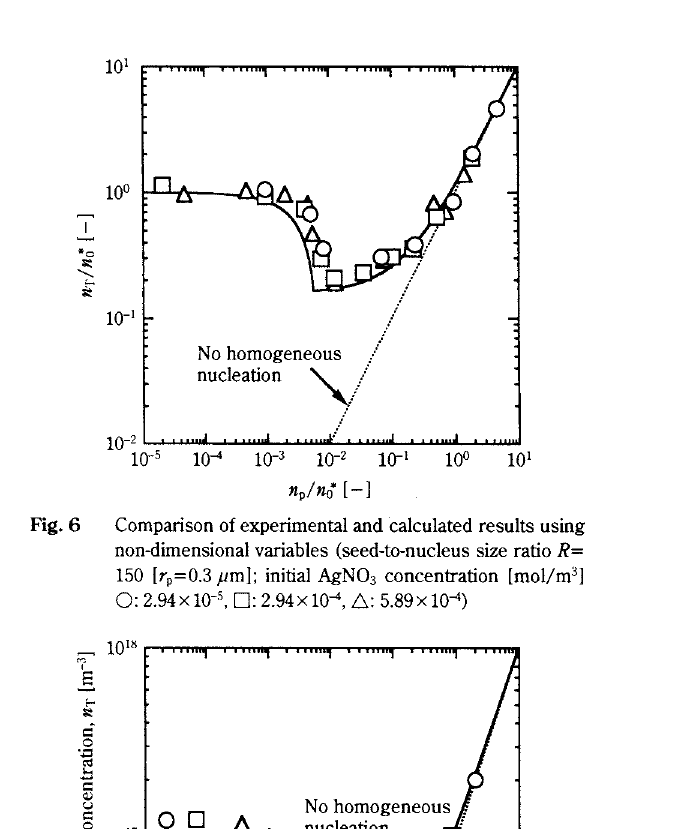
Comparison of experimental and calculated results (initial AgN0 3 concentration 2.94x 10-4 mol/m 3; seed-to-nucleus size ratio R 0: 150, 0: 250, 6: 500).